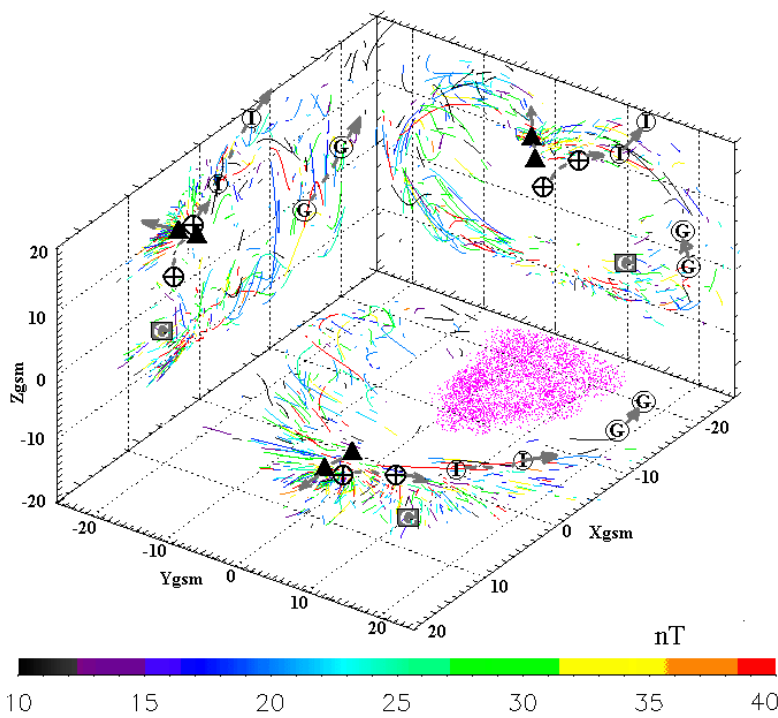
Fig. 8a. TBL in 1995–1998 from Interball-1 magnetic field data in 3 GSM planes. The full standard devi- ation is color-coded according to the scale at the figure bottom and shown at the pieces of orbit traces of Interball- 1 (see the TBL definition in the text). The violet dot-shading marks lack of Interball-1 orbit coverage of the MP. Case studies are shown by symbols (cir- cled crosses and triangles – for Polar and Interball-1 on 29 May 1996, for the remainder of the t symbols, see the